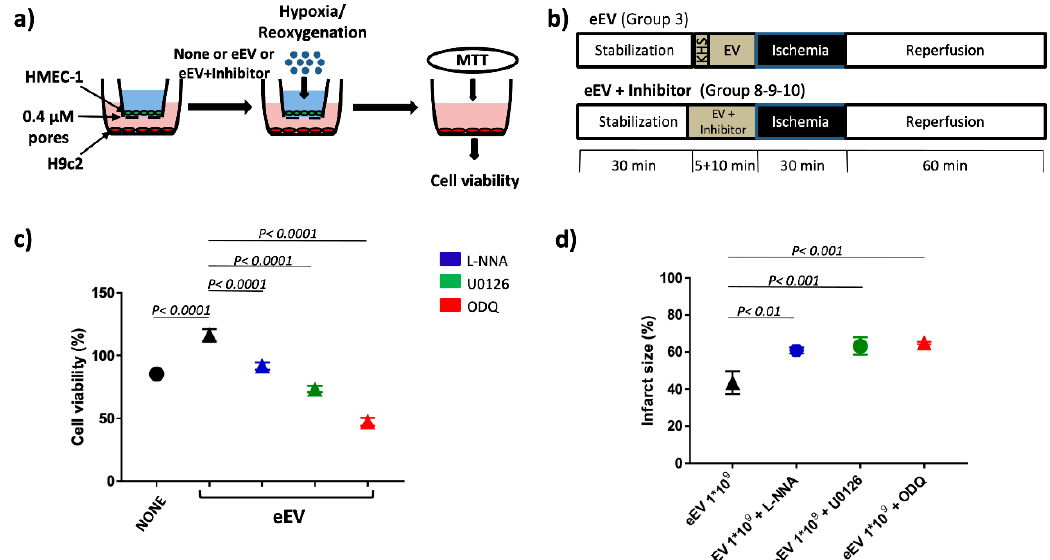
Figure 5. Mitogen-Activated Protein Kinase Kinase (MEK1/2)/endothelial-nitric oxide-synthase (eNOS)/ guanylyl-cyclase (GC) inhibitors prevented cardio-protection in in-vitro and ex-vivo models. ( a ) Representative image of transwell assay of HMEC-1 cells seeded in the upper and H9c2 cells in the lower well. HMEC-1 cells treated or not with eEV or eEV-IL-3 were subjected to H/R condition. MTT assay was performed on H9c2 cells. ( b ) Timeline of ex vivo protocol. Protocols of ischemia (black boxes) and reperfusion (white boxes) in isolated rat hearts. After stabilization (white boxes), Krebs–Henseleit buffer solution (KHS) was infused with eEV and/or inhibitors (gray boxes) via a collateral line. eEV (1 × 10 9 ) for 10 min before ischemia, while inhibitors were given 5 min (total time infusion was 15 min) as indicated. ( c ) Cell viability of H9c2 cells subjected to eEV treatment with different inhibitors in H/R conditions. MEK1/2/eNOS/GC inhibitors abolished eEV-protective effect. p < 0.0001 NONE vs. eEV; p < 0.0001 MEK1/2/eNOS/GC inhibitors vs. eEV. Data were normalized to the mean value of normoxic control (CTRL N). ( d ) Infarct size in isolated rat hearts exposed to eEV and pretreated with different inhibitors. The protective effect of eEV (1 × 10 9 ) was abrogated by pretreatment with the antagonist of MEK1/2, U0126 ( n = 3), the inhibitor of eNOS, L-NNA ( n = 3), and the blocker of GC, ODQ ( n = 3). p < 0.01 eEV vs. eNOS inhibitor; p < 0.0001 eEV vs. MEK1/2 and GC